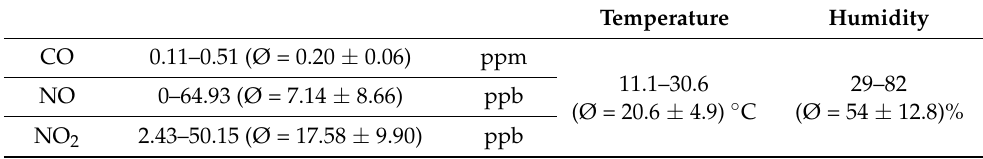
Table 6. Average concentrations, temperature, and humidity of the reference